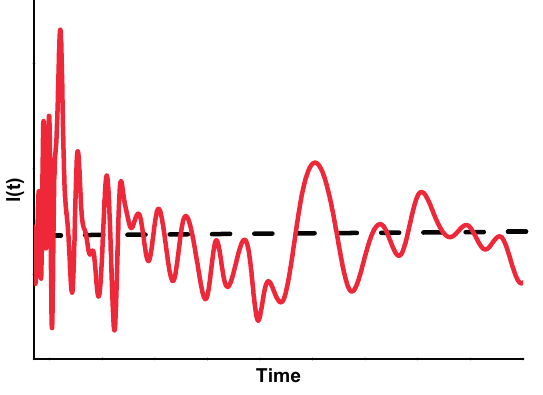
Figure 3. The fluctuation of scattered light over time (in the range of milliseconds). The dotted line represents the SLS-signal and the red line represents the